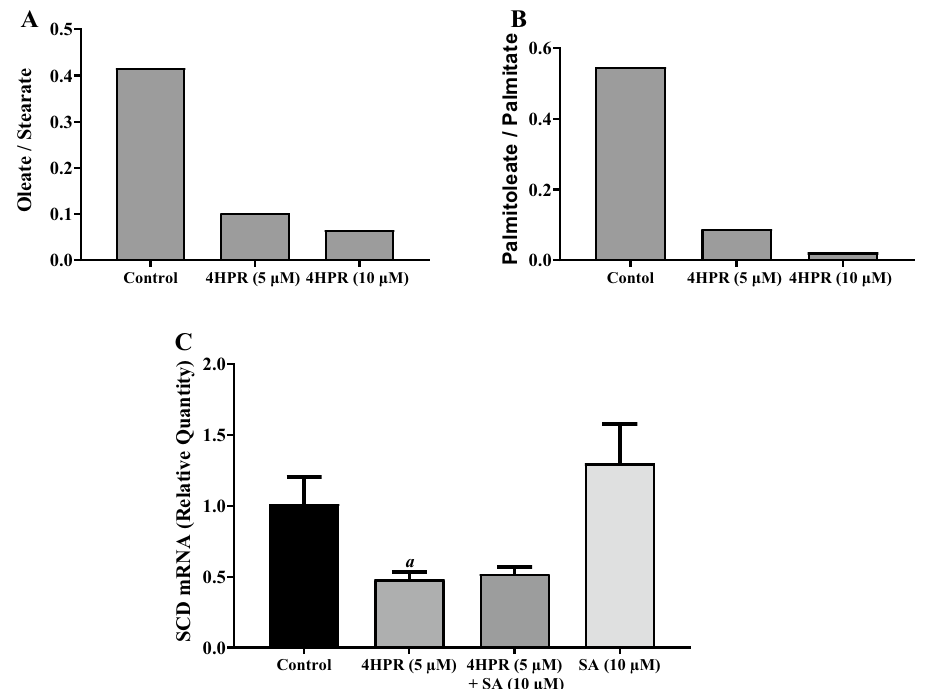
Figure 3. SCD enzyme activity is decreased by fenretinide in ARPE-19 cells. ARPE-19 cells were treated with or without fenretinide (4HPR) for 16 h before incubating with 50 M methyl-D3-stearate or 50 M methyl- D3-palmitate for 5 h. Lipids were extracted then analyzed by LC–MS. ( A ) The histogram shows the effect of fenretinide on the ratio of oleate to stearate. ( B ) The histogram shows the effect of fenretinide on the ratio of palmitoleate to palmitate. ( C ) Fenretinide-induced SCD mRNA expression is prevented by pretreatment of cells with SCD inhibitor sterculic acid (SA). The ARPE-19 cell cultures were treated with fenretinide in the presence or absence of SA, and the total RNA preparations were analyzed by qPCR as described under “Experimental Procedures”. The values are mean ± SD of three independent experiments performed in quadruplicate. To test for significant differences between treatment groups, one-way analysis of variance (ANOVA) was used. In the graphs, ‘ a ’ indicates statistical significance difference between fenretinide treated cells and untreated controls ( a p <